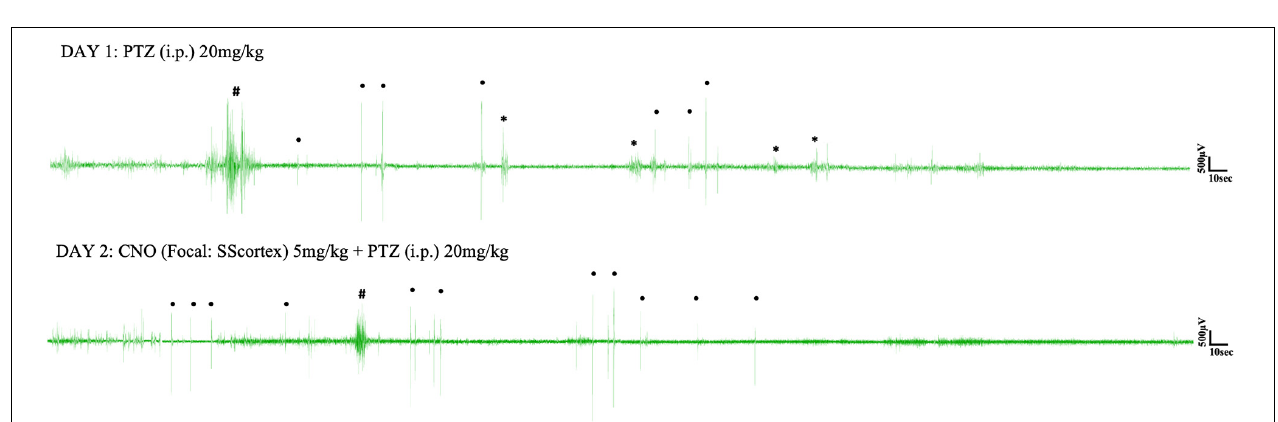
FIGURE 4 | Schematic of protocol for EEG recordings before and after (A) PTZ injection on day 1 and (C) PTZ and CNO injection on day 2. Comparison of the percentage of different types of seizures in PV Cre /Gq-DREADD (DREADD) ( n = 7) and non-DREADD WT control ( n = 5) animals of the SScortex and the RTN thalamus group after (B) PTZ injection on day 1 and (D) PTZ and CNO injection on day 2.